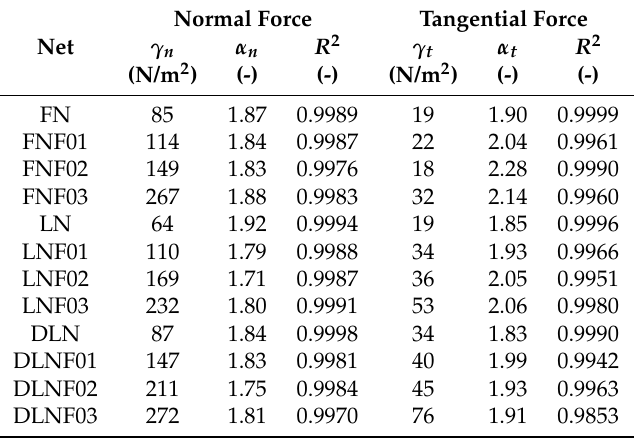
Table 3. Coefficients γ and α for f D = γ V α fitting for normal and tangential